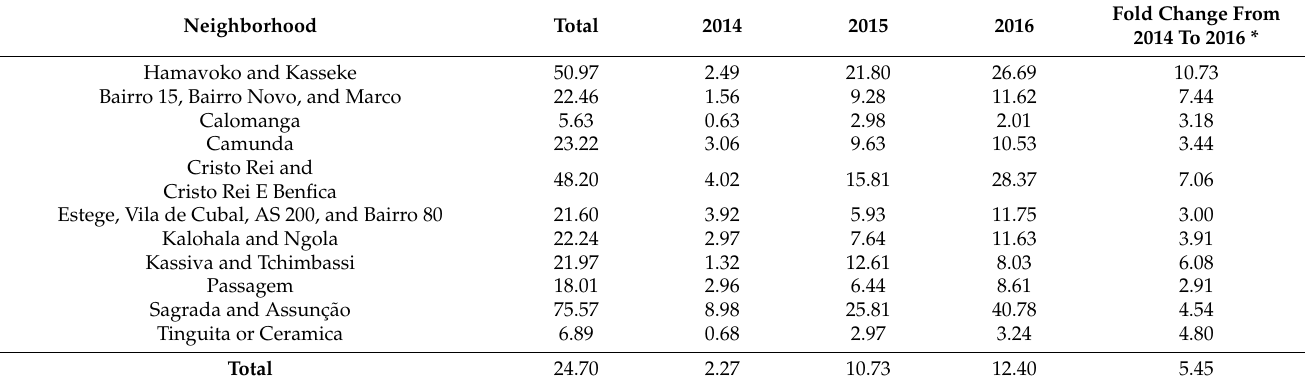
Table 2. Incidence rates (cases per 1000 inhabitants) by neighborhood in Cubal, Angola, 2014 to 2016. Neighborhood Total 2014 2015 2016 Hamavoko and Kasseke 50.97